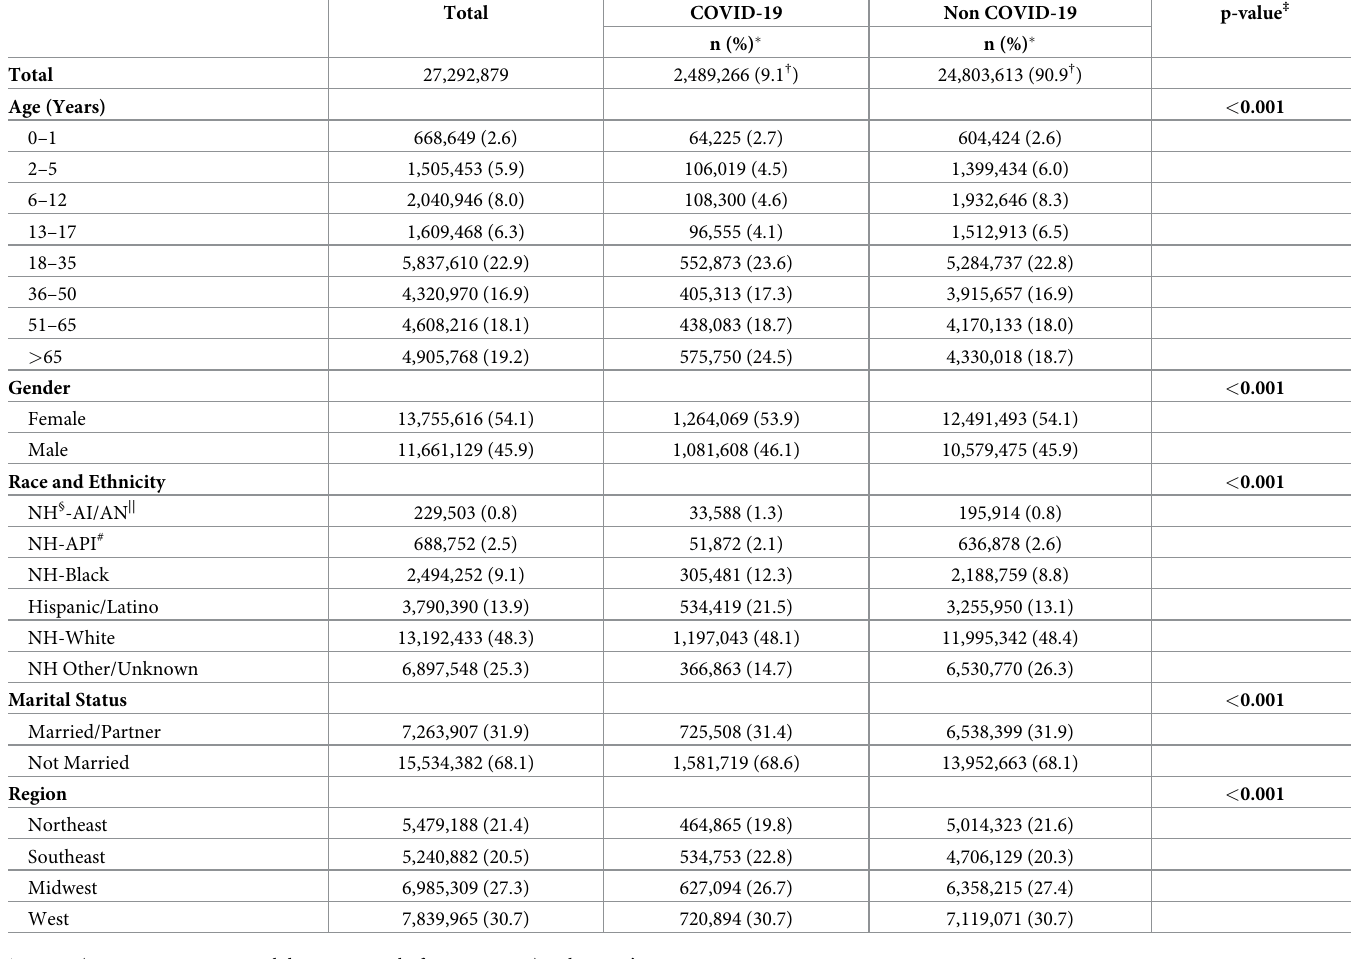
Table 1. Demographic characteristics of patients with no history of T1D (overall and stratified by COVID-19